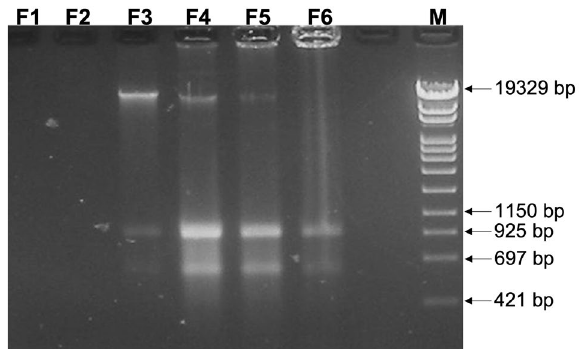
Figure 1. Electrophoretic analysis of the nucleic acids associated to fractions F3 and F4 of S. coelicolor MVs. M: DNA Molecular Weight Marker IV